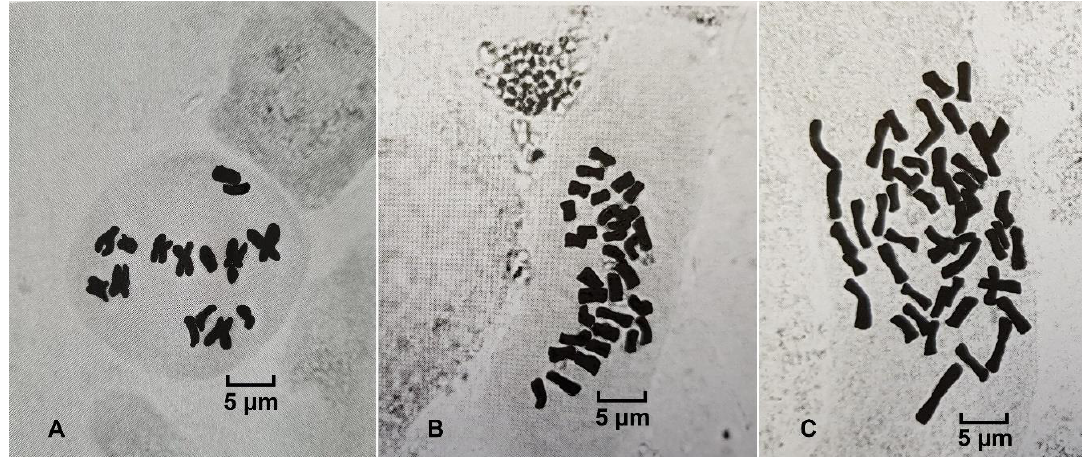
Figure 7. The metaphase plates of R. circinatus (2n = 16) from the Gruda River ( A ), putative R. circinatus × R. penicillatus (2n = 32) from the Skroblus River ( B ), and R. penicillatus (2n = 48) from the Ula River ( C ).